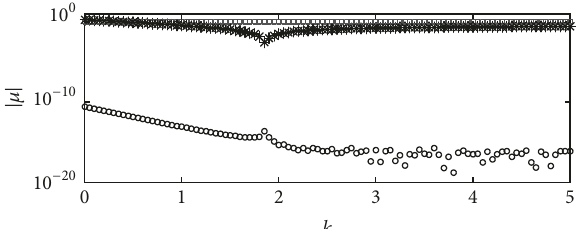
Figure 20: Magnitude of the Floquet multipliers for different values of 𝑘 for the TUPO4 controlled by the aPBC.